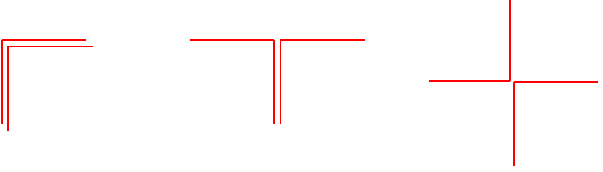
Figure 4. Different corner combinations that are associated by the corner associator regardless of the direction of the